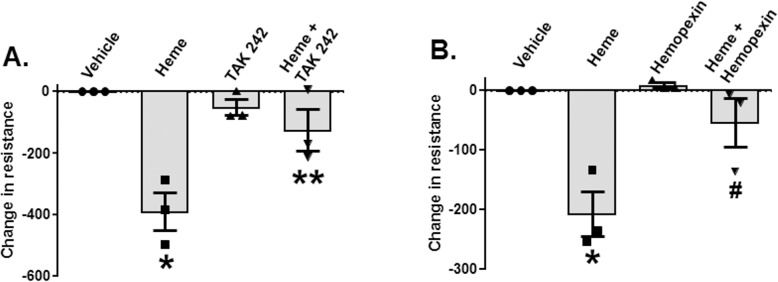
Heme-dependent decreases in endothelial barrier resistance are TLR4-dependent.Rat microvascular endothelial cell (RMVEC) monolayers were seeded in Electric Cell-substrate Impedance Sensing (ECIS) arrays as described in Methods. When monolayers reached the appropriate resistance, monolayers were treated with vehicle or heme (10 μM, n = 3) alone or in the presence of TAK-242 (150 μg/ml TAK-242 was added 30 min before administration of heme, n = 3) (A) or 10 μM hemopexin (n = 3) (B). Resistance was measured every 10 min for 8 h. Changes in resistance after 8 h were calculated and vehicle effects subtracted. Decreases (i.e., negative values) in resistance indicate increases in permeability. Data are mean ± SEM (n = 3), with each symbol representing an independent experiment. *p = 0.002 and **p = 0.003 relative to vehicle and $p = 0.018 and #p = 0.019 relative to heme determined by repeated measures 1-way ANOVA with Tukey post-test.